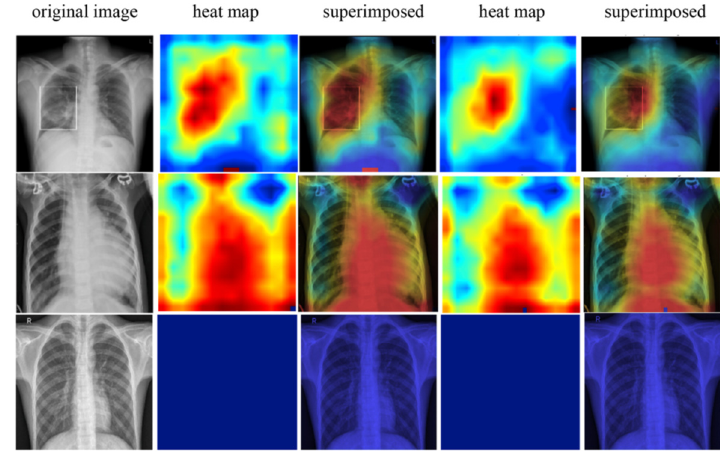
Figure 12. COVID-19 detection and diagnosis [81].